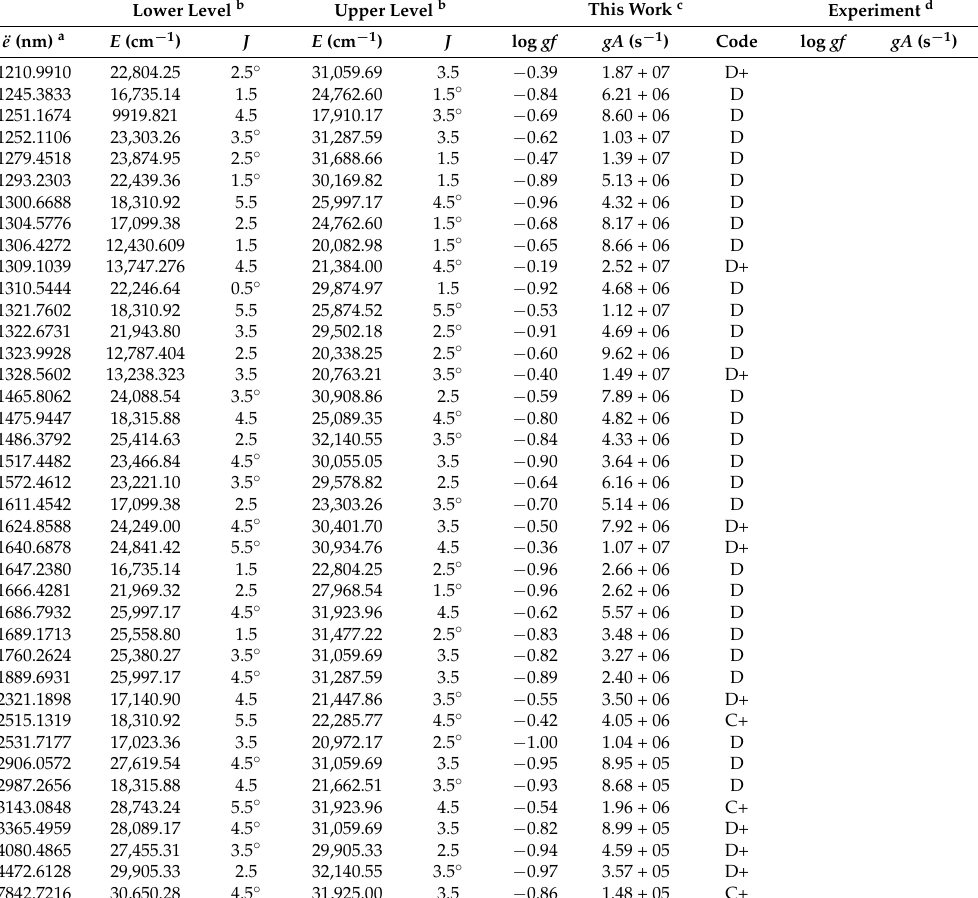
Figure 5. Comparison between the oscillator strengths (log gf ) computed in the present work using the MCDHF model and the available experimental values [22]. The dashed line corresponds to a perfect agreement while the dotted lines correspond to a discrepancy of a factor of two on the gf ‐ values.